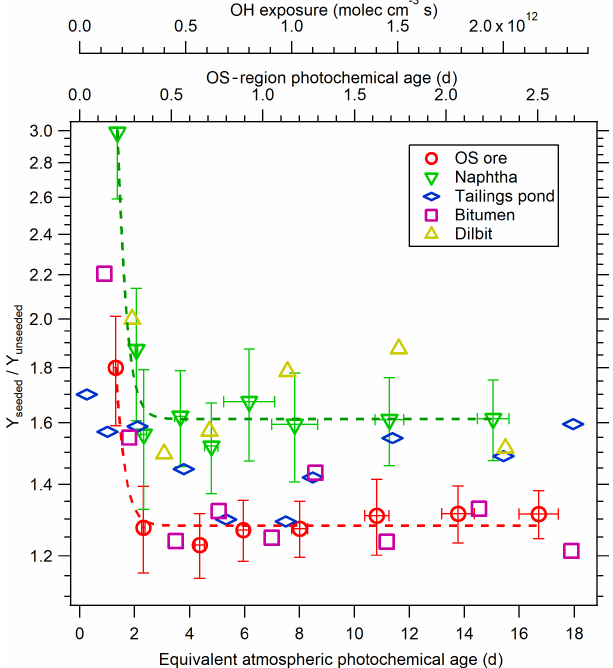
Figure 6. Yield enhancement factor due to seed particles for OS- related precursors. Dashed lines are exponential fittings for naphtha and OS ore data; error bars indicate ± 1 σ uncertainty in measure-